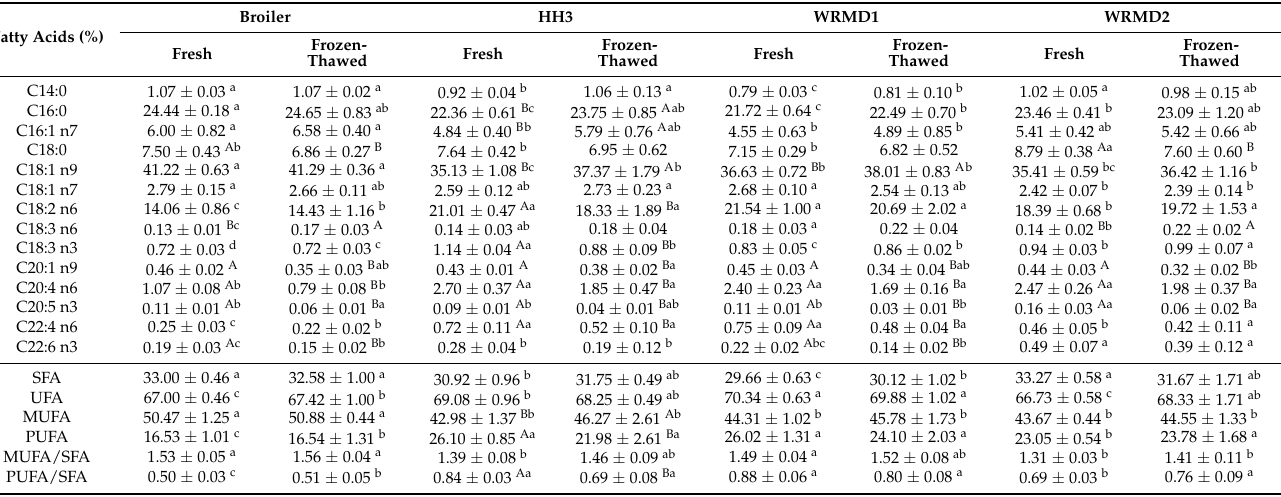
Table 5. Comparison of fatty acid composition of fresh and Frozen-Thawed chicken thigh meat from Korean native chickens and